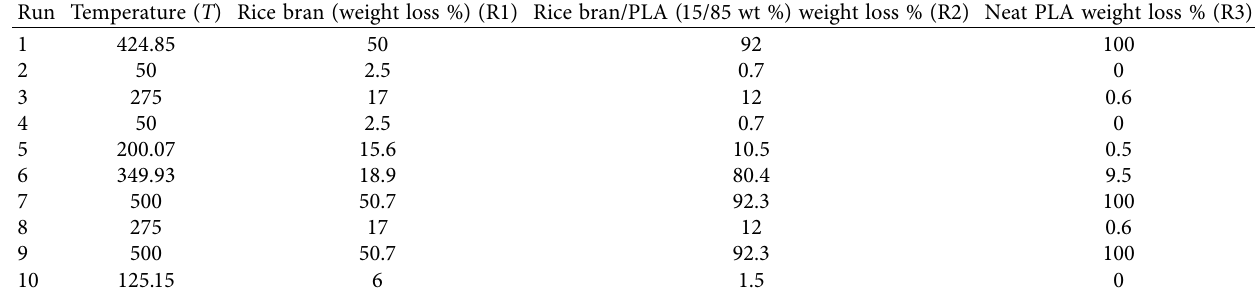
Table 7: Values of weight loss for rice bran weight loss, rice bran PLA composite weight loss, and neat PLA weight loss as per the 10 primary values of the T factor.